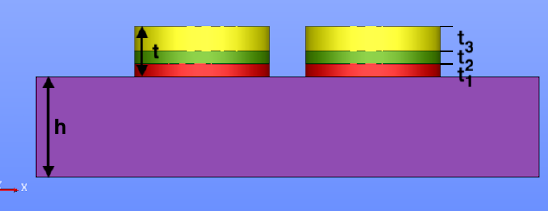
Figure 17. Plasmonic nanoantenna of Figure 13 with the gold nanoparticles divided in three layers with heights t 1 = 10 nm, t 2 = 10 nm, and t 3 = 20